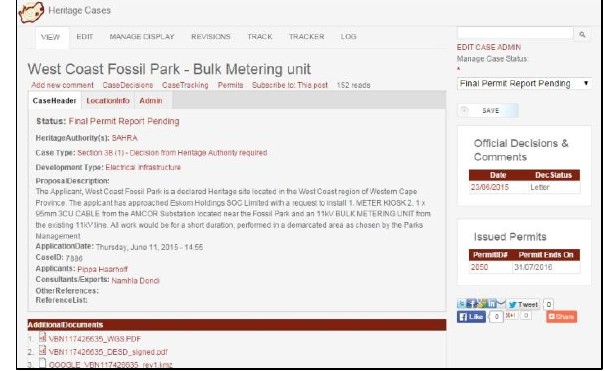
Figure 3: Example of a permit application on